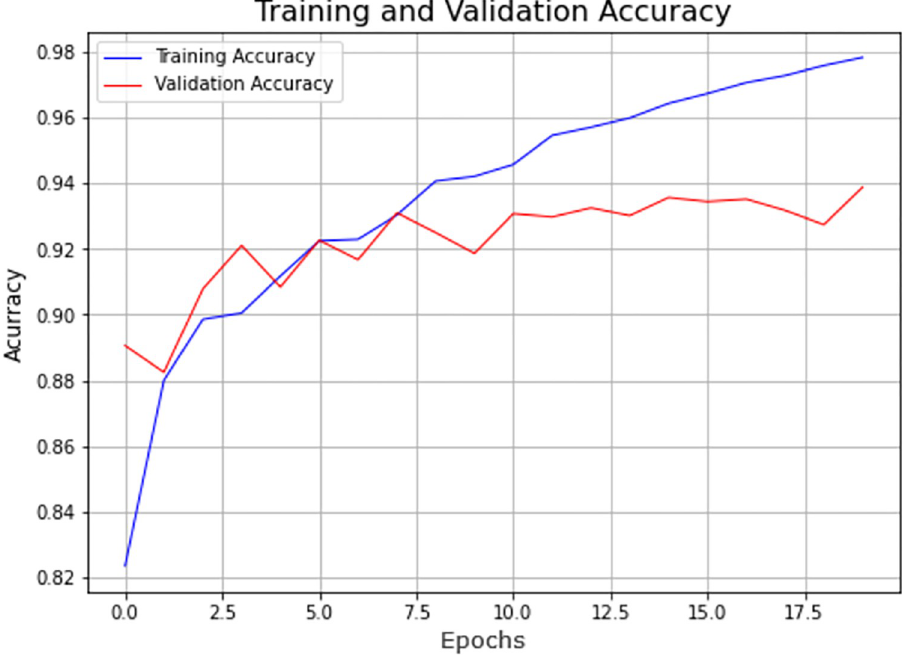
Fig 8. Accuracy measures for VGG-16